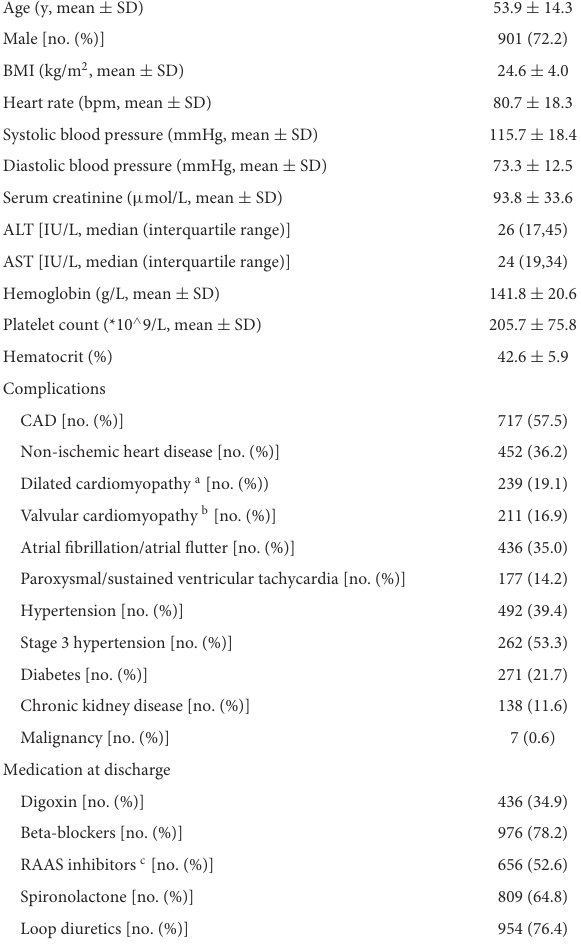
TABLE 1 Baseline characteristics of heart failure patients with intracardiac thrombi.